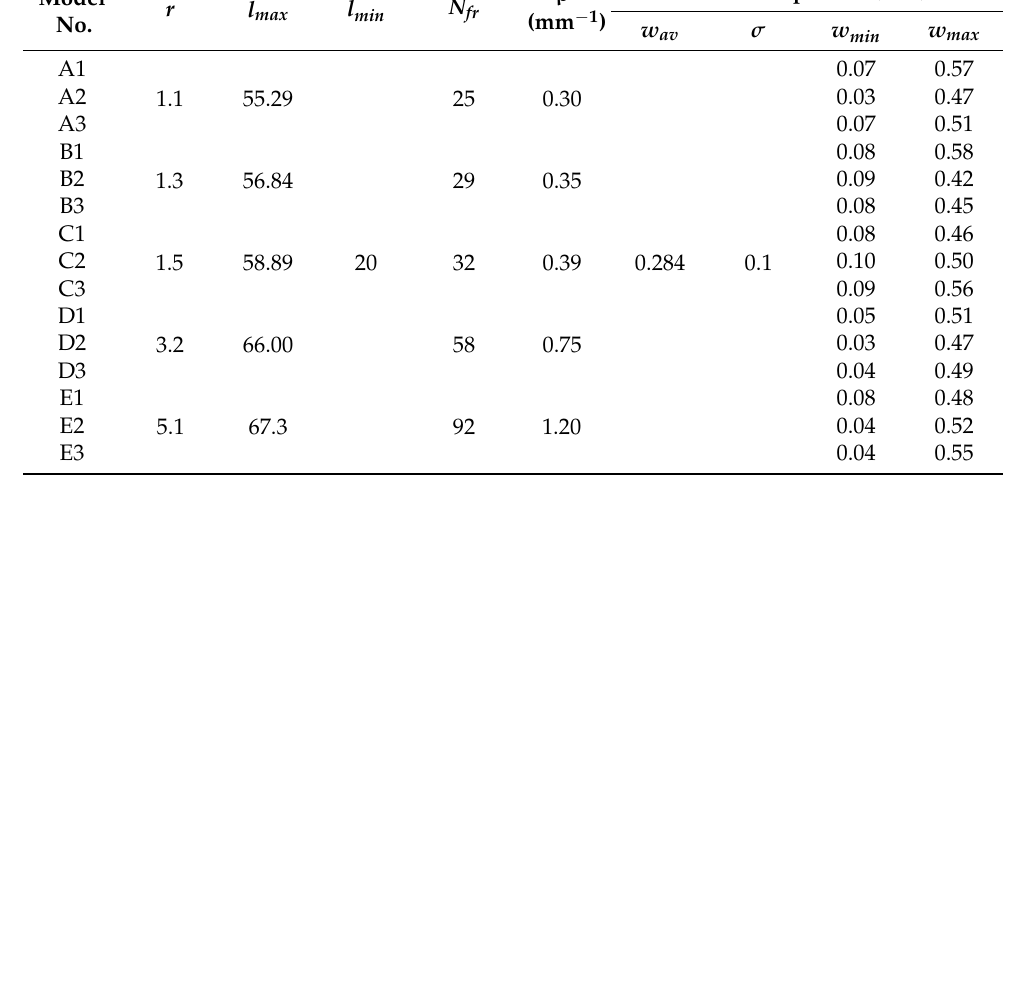
Table 1. The initial geometric parameters of the fracture networks.